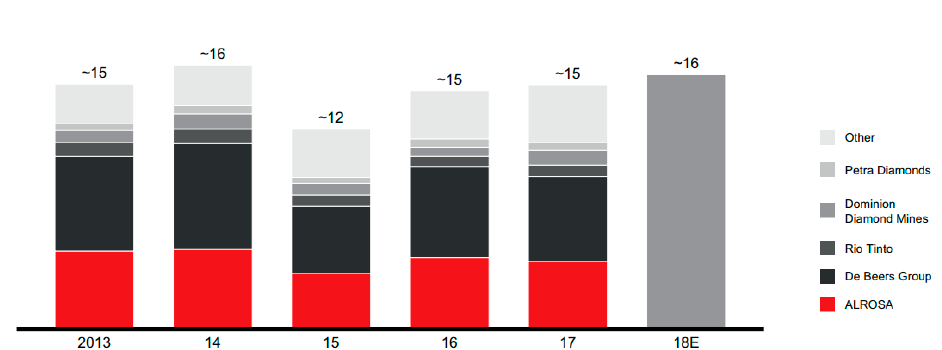
Figure 4. Sales of rough diamonds by producers in billions of dollars, including inventories (2013–2018). Notes: The figure presents major diamond mining companies and producers of rough diamonds in billions of dollars. Estimated realized price is based on an estimate of carats sold if data is published, if not, based on production data. ALROSA revenues represent diamond sales only. Dominion Diamond Mines 2017 results based on H1 2017 as the company was delisted and no longer publishes the data. Petra Diamonds data converted from year ending in June to year ending in December, based on company reports for full year and half year. Only diamonds tracked by Kimberley Process are included. Other is estimated assuming no price change for the players of this segment. E is an estimate. In order to estimate average price per carat sold, total value of diamonds sold is divided by total volume of diamonds sold. Source : (Bain and Company, Antwerp World Diamond Center 2018).